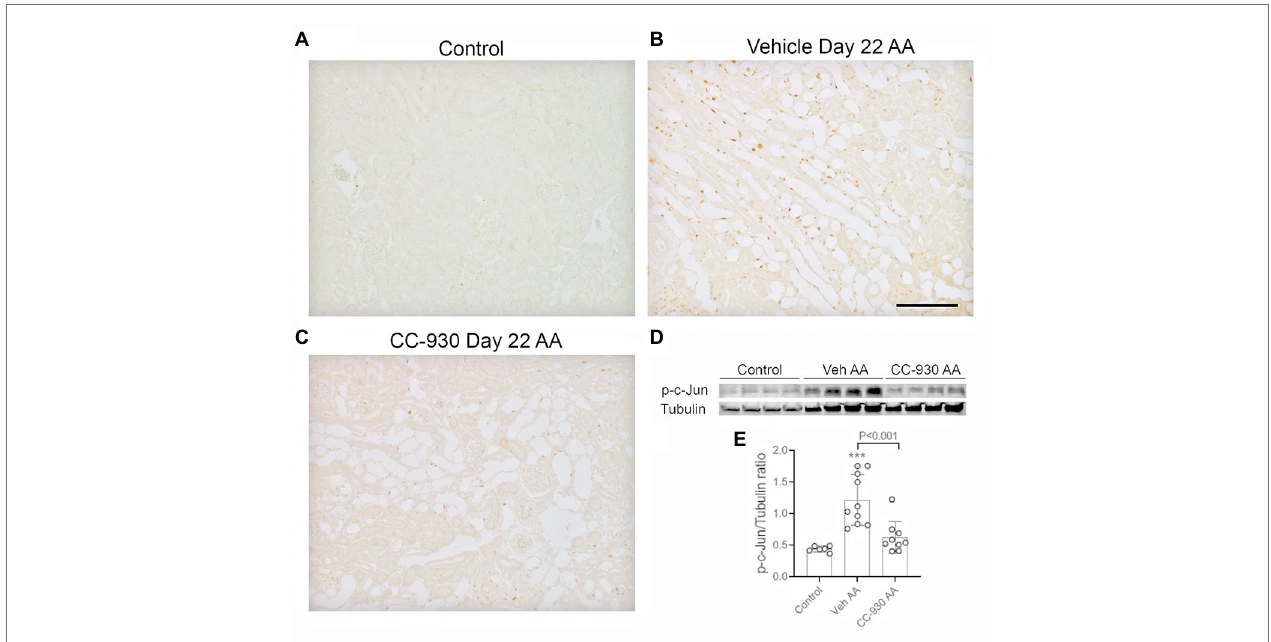
FIGURE 7 | JNK signaling on day 22 of aristolochic acid (AA) induced chronic kidney disease. Vehicle and CC-930 treated AA groups were compared to normal controls. (A–C) Immunohistochemistry staining for phospho-c-Jun Ser 63 . (A) Normal control kidney shows very little p-c-Jun staining. (B) Vehicle treated AA shows tubular cells with nuclear staining for p-c-Jun, being most prominent in dilated and atrophic tubules. (C) CC-930 treated AA showing a very substantial reduction in p-c-Jun+ cells. Bar represent 100 μ m. (D) Western blot of kidney lysates for p-c-Jun and reprobed for α -tubulin. (E) Graph showing quantification of Western blots. One-way ANOVA with Tukey’s multiple comparison test. *** p < 0.001 vs.